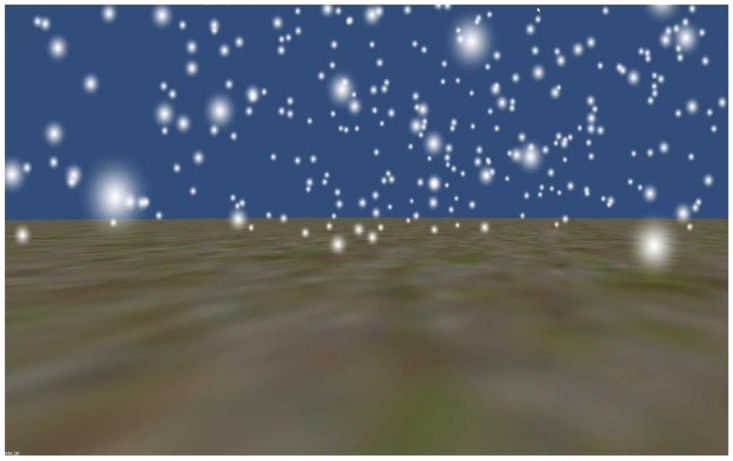
Visual scene.To provide disparity information, the visual stimuli were presented stereoscopically using a dual-projector setup. The figure only shows the image presented by one projector.